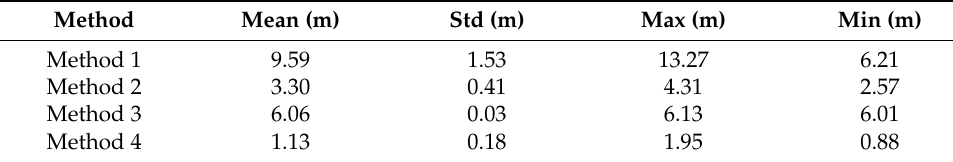
Figure 10. Analysis of the measurement delay error. ( a ) The delay error of the buoy 1; ( b ) the delay error of the buoy 2; ( c ) the delay error of the buoy 3; ( d ) the delay error of the buoy 4. Using the ray model, we can calculate the true measurement delay of the positioning signals when the AUV is in any position. Figure 10 shows the comparison result of the measured delay error with and without the time delay calibration. It can be seen that after time calibration, the measurement delay error is significantly smaller. Figure 11 shows the positioning results of the AUV with different methods. The blue line in the figure is the positioning error obtained without the spatial-temporal calibration or the sound ray correction. With sound ray correction, the orange + line and the red O line correspond to the positioning result after spatial calibration and time calibration, respectively. The purple ∗ line is the positioning error corresponding to the algorithm proposed in this article, and the blue line is the positioning error corresponding to the PCRB threshold. Table 2 shows the statistical results of the horizontal error. Methods 1 to 4 (cid:1) in the table correspond to the methods represented by the first four curves in the annotation box in the upper right corner of Figure 11. It can be seen from the data in the table that the algorithm (method 4) proposed in this paper reduces the positioning error and improves the horizontal positioning accuracy. Table 2. Comparison of the position results of different